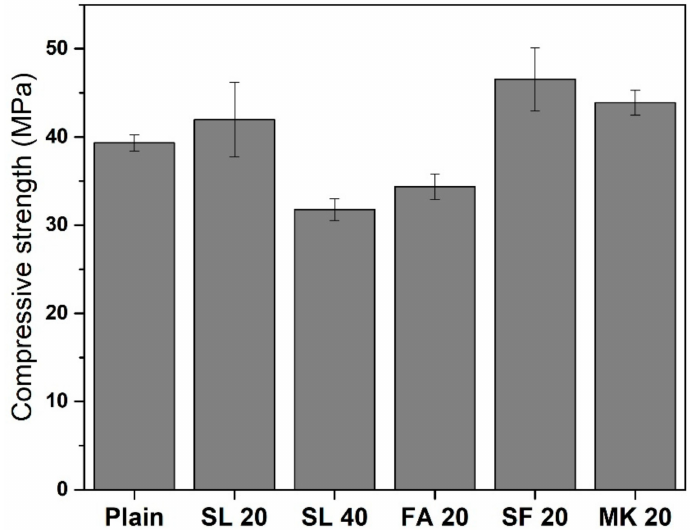
Figure 10. The 28-day compressive strength of concrete with various